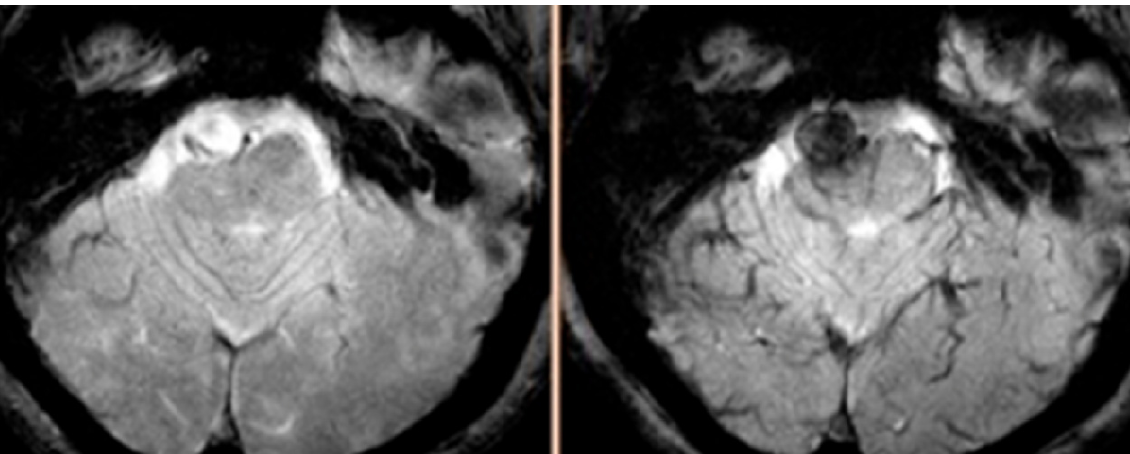
Figure 2. MRI, T2* GE sequence, from a patient showing early uptake of ferumoxytol. The aneurysm ruptured within three